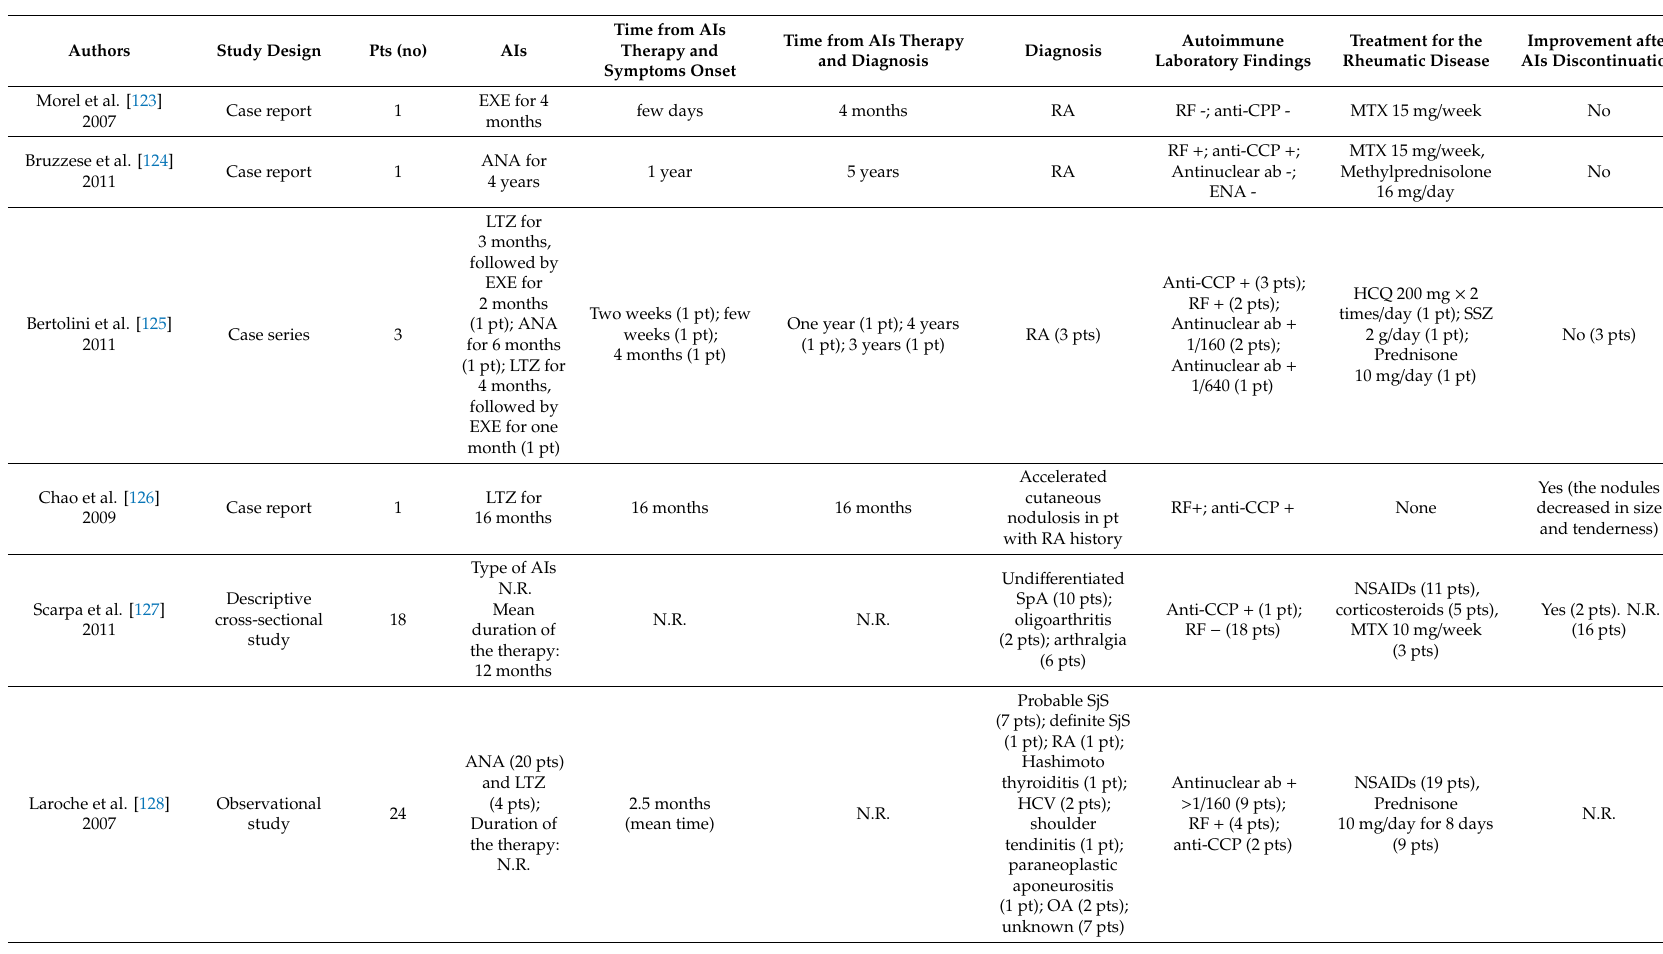
Table 3. Characteristics of the clinical studies reporting an association between Aromatase Inhibitors (AIs) therapy and autoimmune rheumatic diseases.